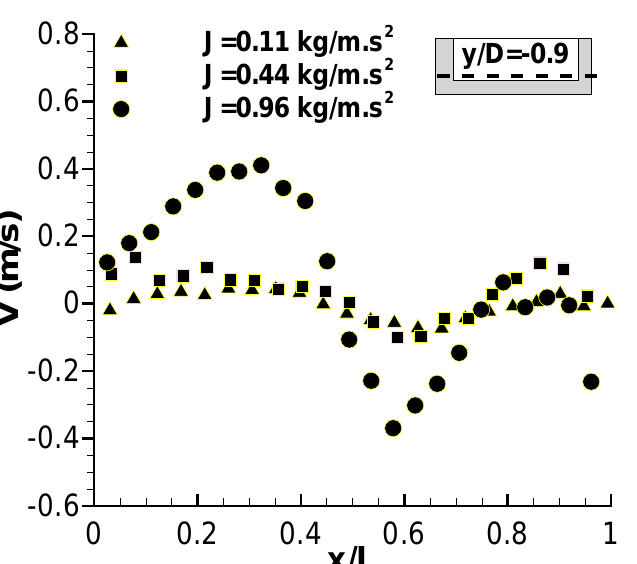
Figure 6. The time-averaged V velocity distribution along y / D = − 0.9 for actuator with the cavity model [quiescent condition] with different J values.